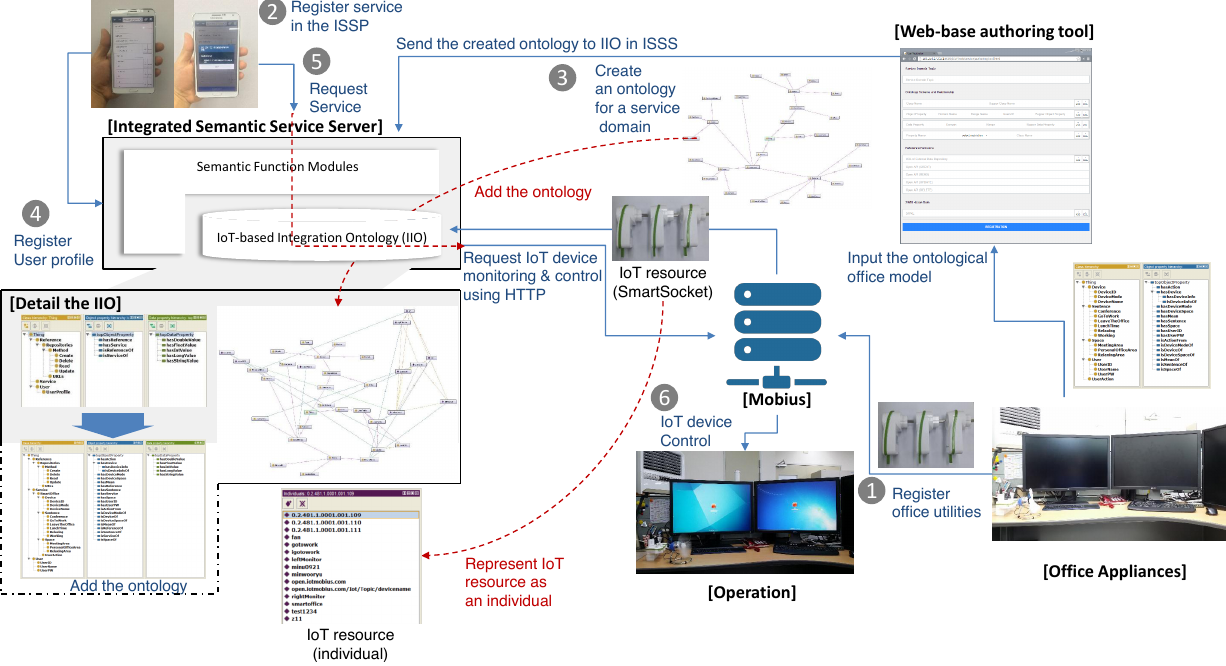
Figure 10. Evaluation process of the